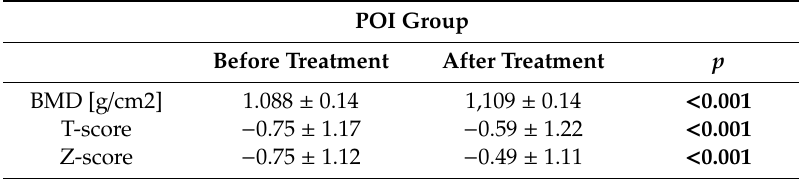
Table 2. BMD in POI group before and after treatment.